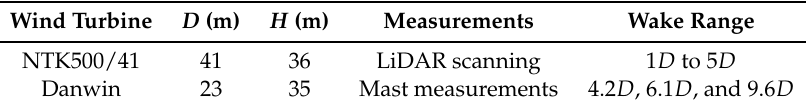
Table 2. Details of measurements in the two test cases.